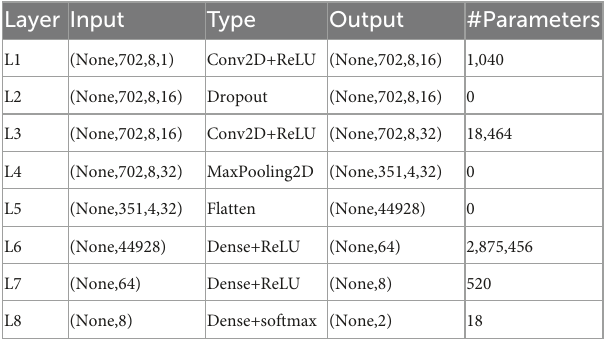
TABLE 1 Convolutional neural network (CNN) structure of two-person parallel data fusion.